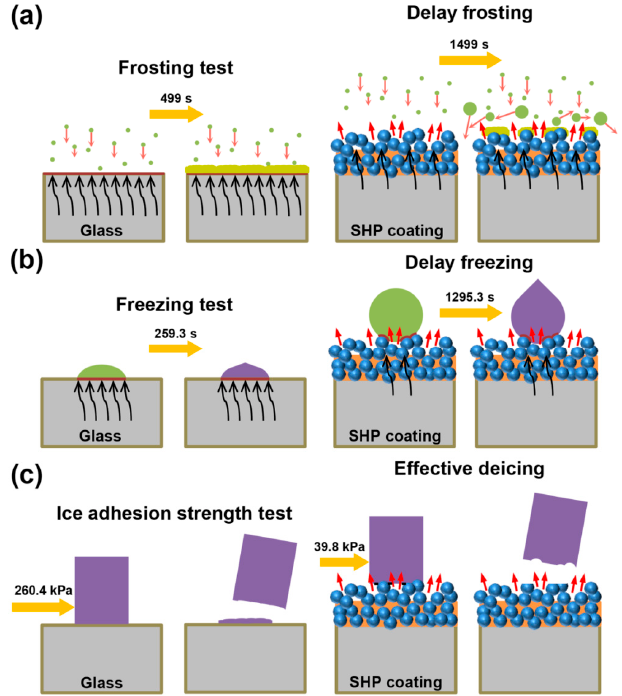
Figure 10. Schematic diagram of anti-frosting ( a ), anti-icing ( b ) and icephobic ( c ) mechanisms of SHP coating.